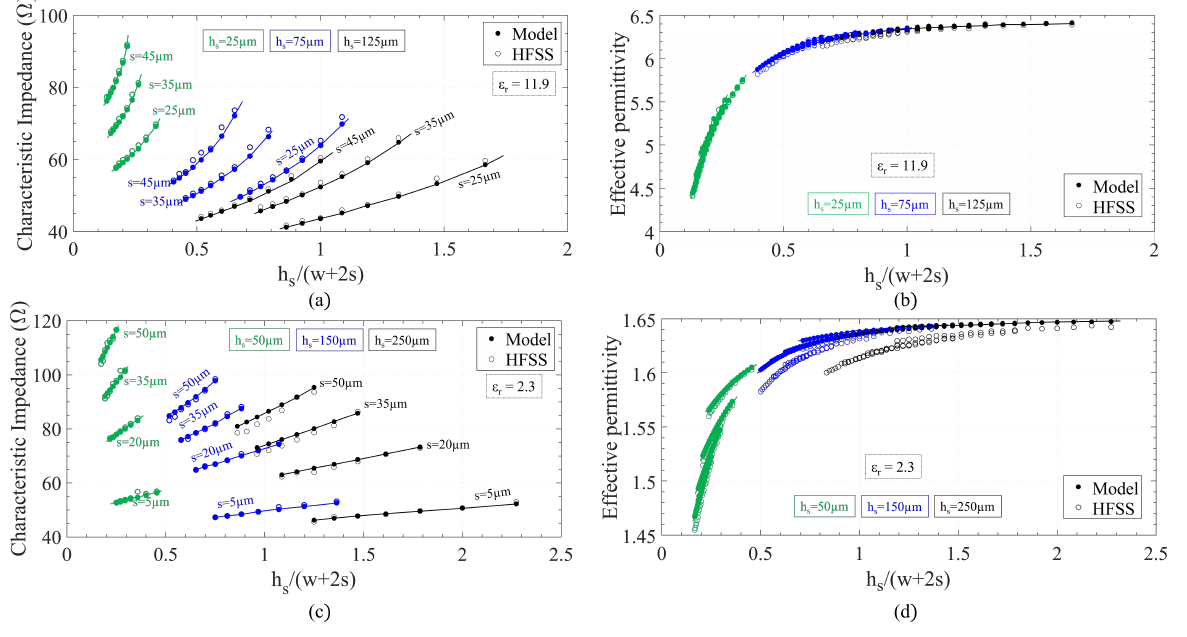
Figure 4. Comparison between closed-form expressions and finite element simulations for the open GapCPW line. ( a ) Z 0 for high-permittivity substrate. ( b ) (cid:101) ef f for high-permittivity substrate. ( c ) Z 0 for low-permittivity substrate. ( d ) (cid:101) ef f for low-permittivity